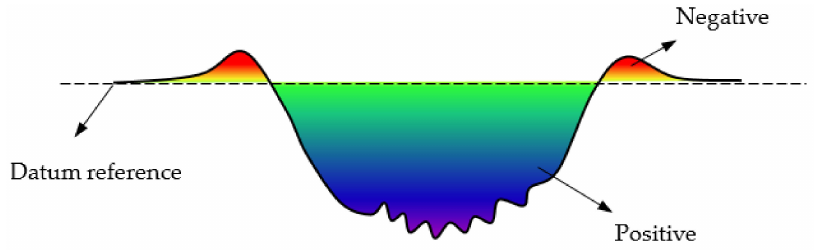
Figure 4. The sketch map for evaluating the wear